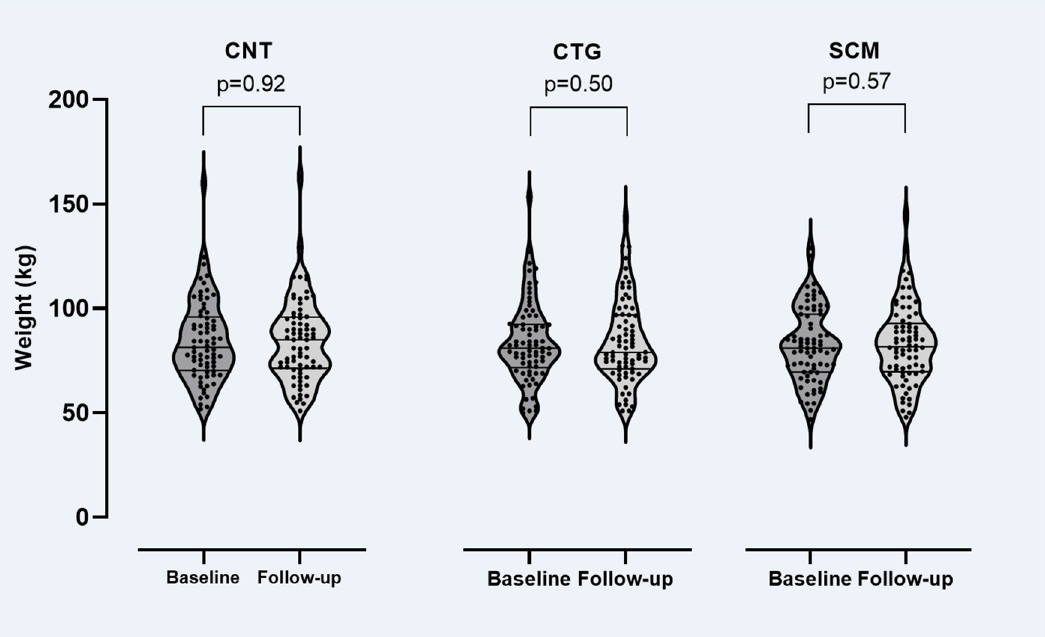
Figure 1. Weight by study arm at baseline and follow-up of the RCT (see main text for details). CNT = control study arm, CTG = genotype-guided study arm, SCM = structured clinical monitoring arm. Paired t-test was used for the comparisons. Table 4. Multiple linear regression. Average weight